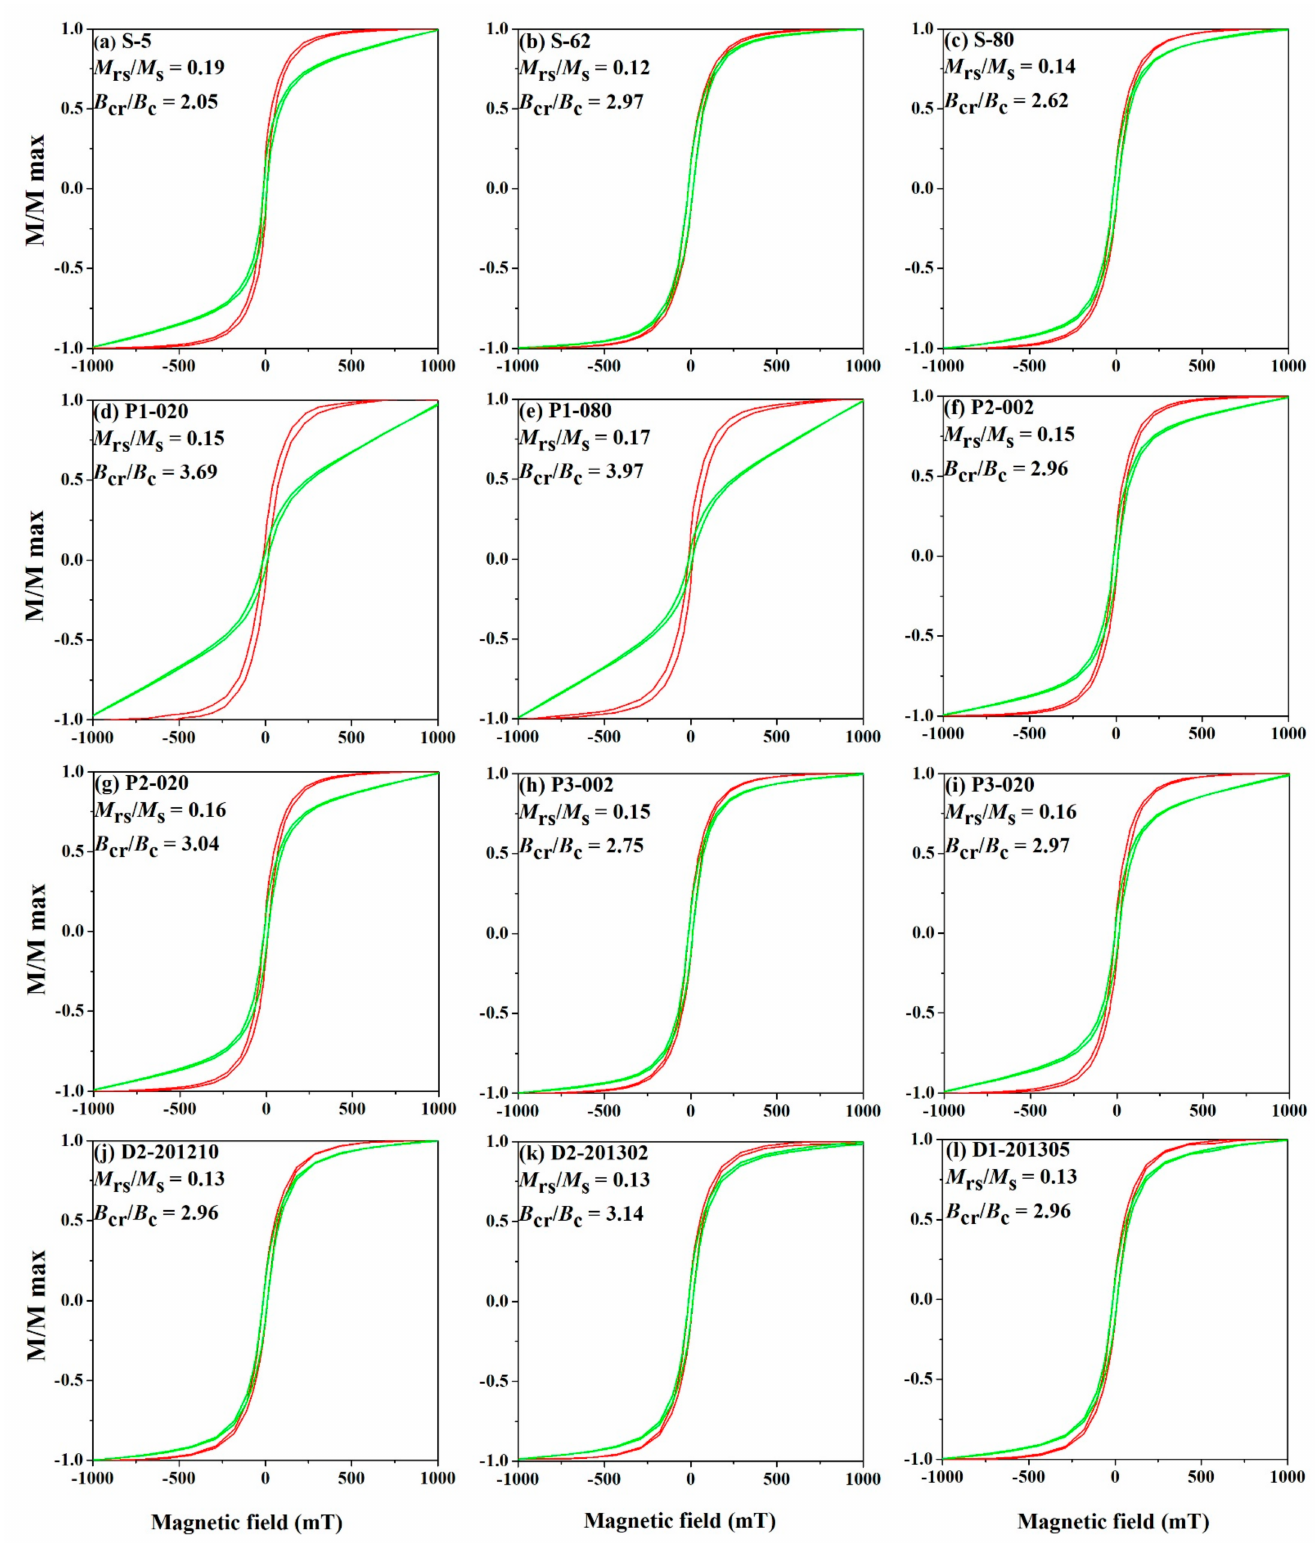
Figure 6. Magnetic hysteresis loops for representative samples following before (green line) and after (red line) subtraction of the paramagnetic